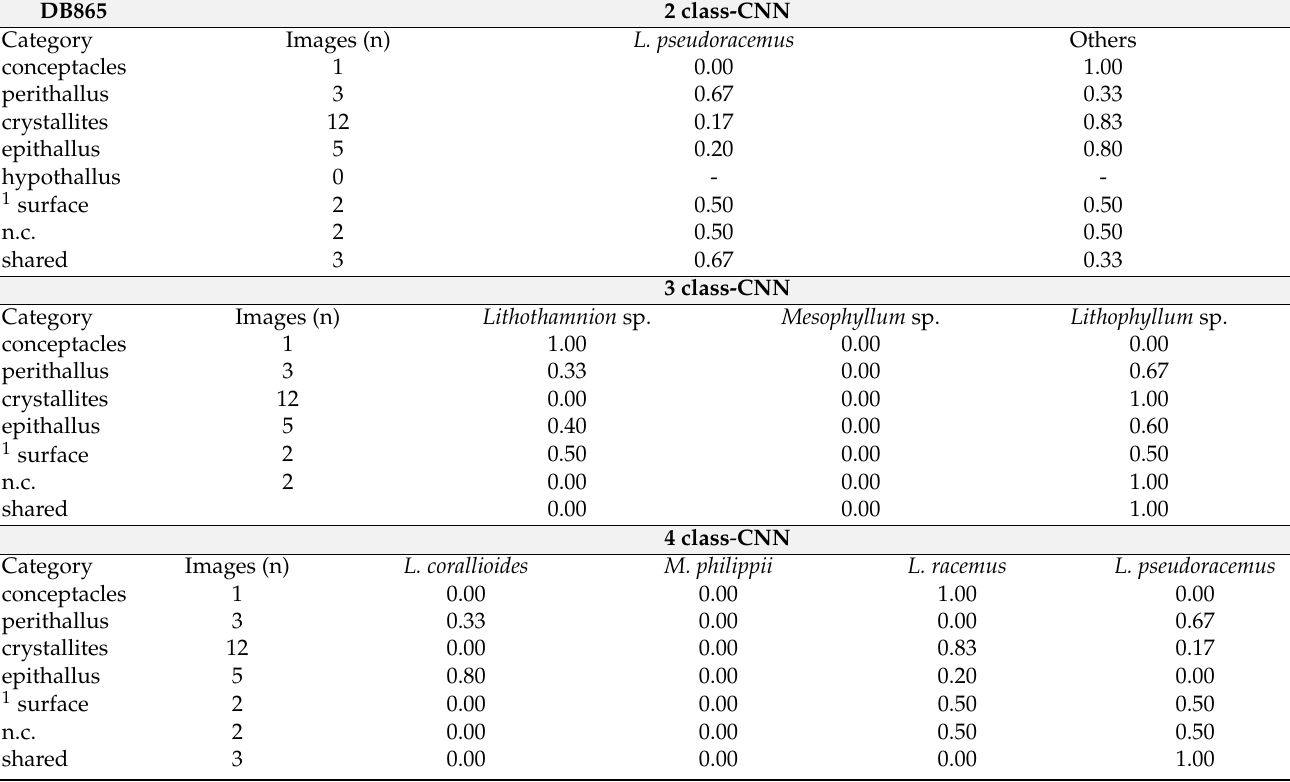
Table 5. The Class Share of sample DB865 has been reported for each assigned category (rows) and class (columns). The total number of SEM images in every predicted class of the three models ( L. pseudoracemus versus other species, genus level and species level) are listed. Images not assigned to a category (n.c.) and showing more than one category (shared) are also included.